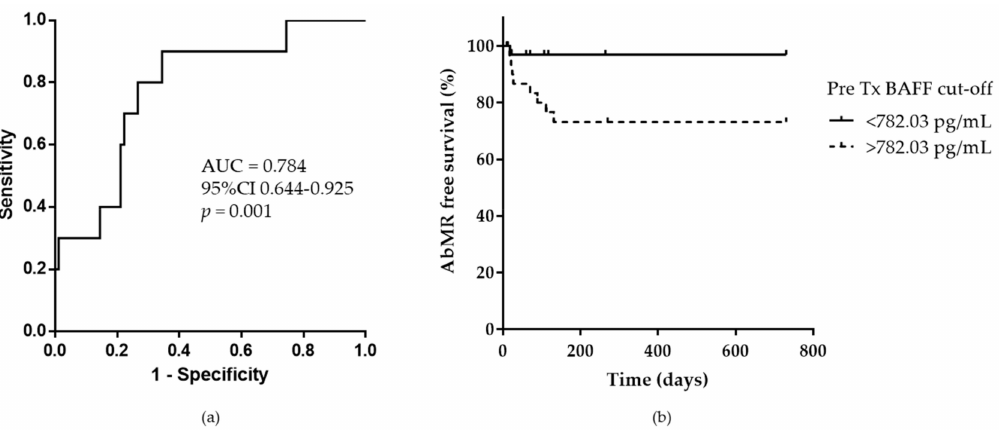
Figure 2. ( a ) Receiver operational curve analysis of BAFF levels before transplantation and the development of antibody-mediated rejection (AbMR) during the first 12 months after kidney transplantation. The area under curve (AUC) is 78.4%. Based on Youden’s index, a cut-o ff of 782.03 pg / mL pretransplant BAFF levels discriminate between clinical AbMR and non-rejection in the first 12 months after kidney transplantation with a sensitivity and specificity of 80% and 73.3%, respectively. ( b ) AbMR free survival between patients with BAFF levels higher and lower than 782.03 pg /